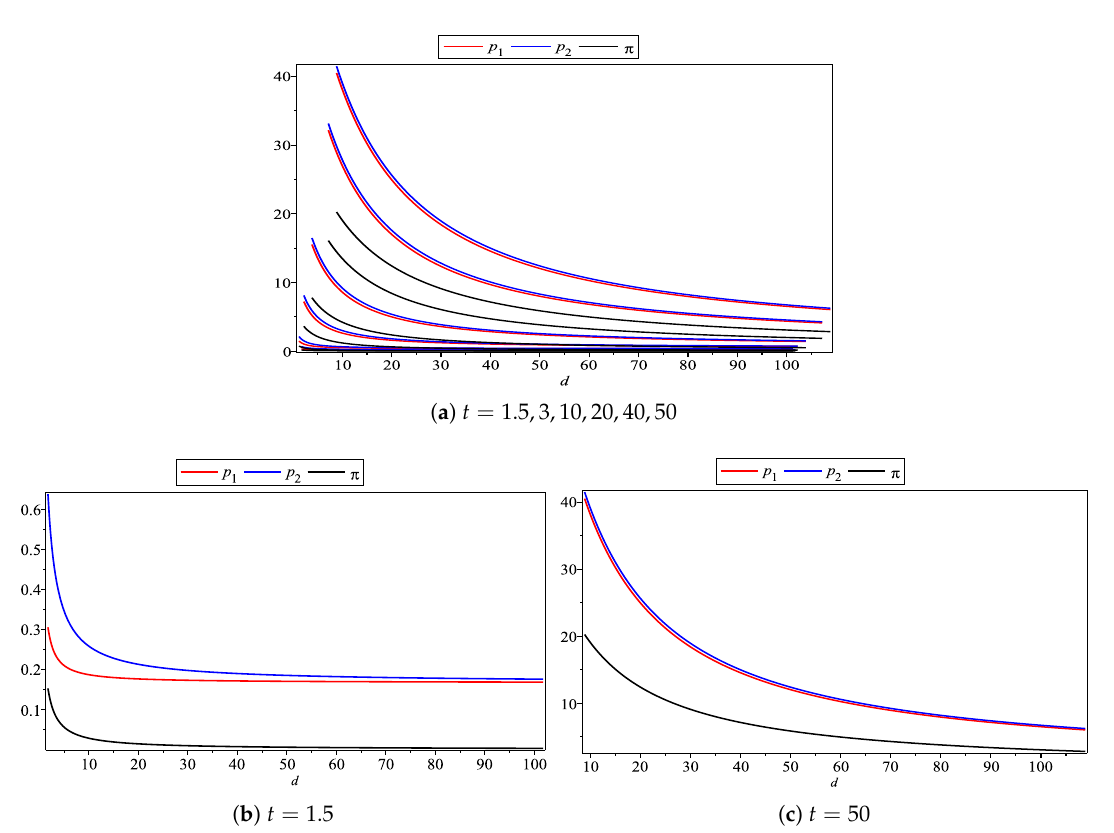
Figure 5. Social effect of CEA on enterprise pricing and